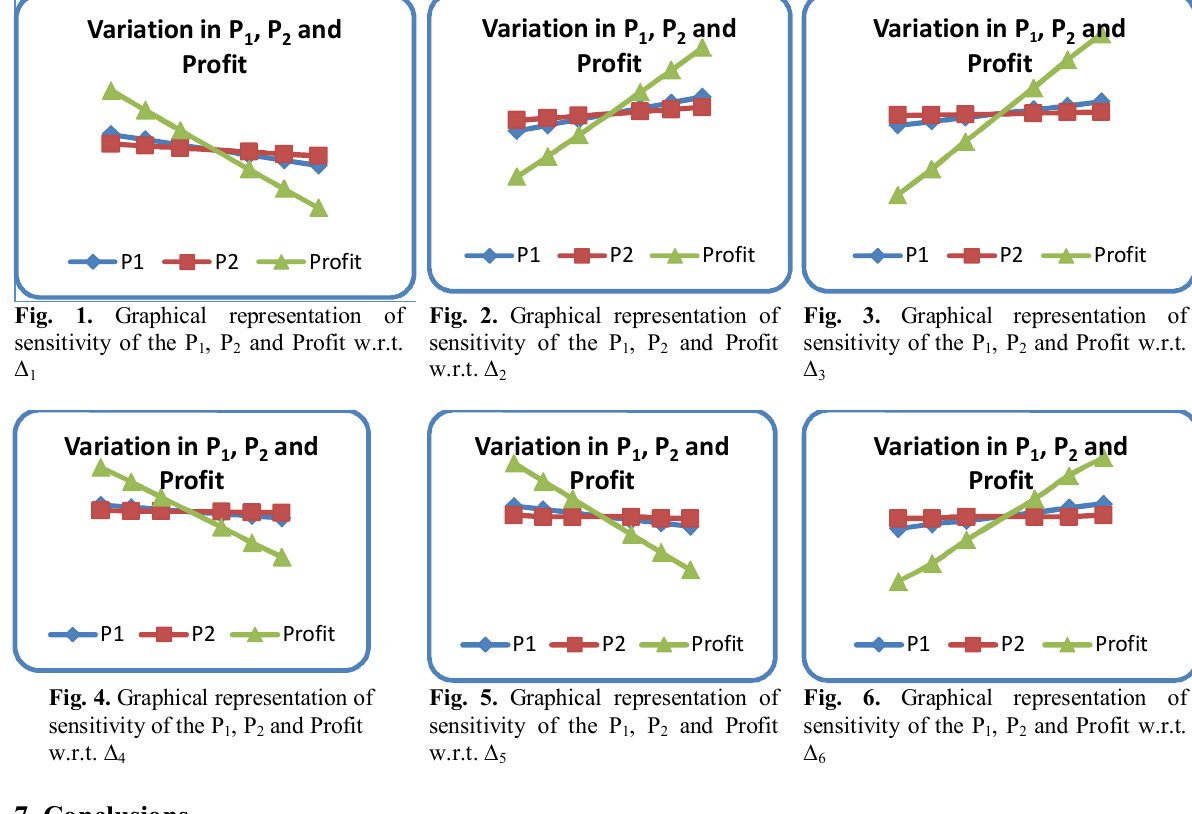
Fig. 4. Graphical representation of sensitivity of the P 1 , P 2 and Profit w.r.t. ∆ 4